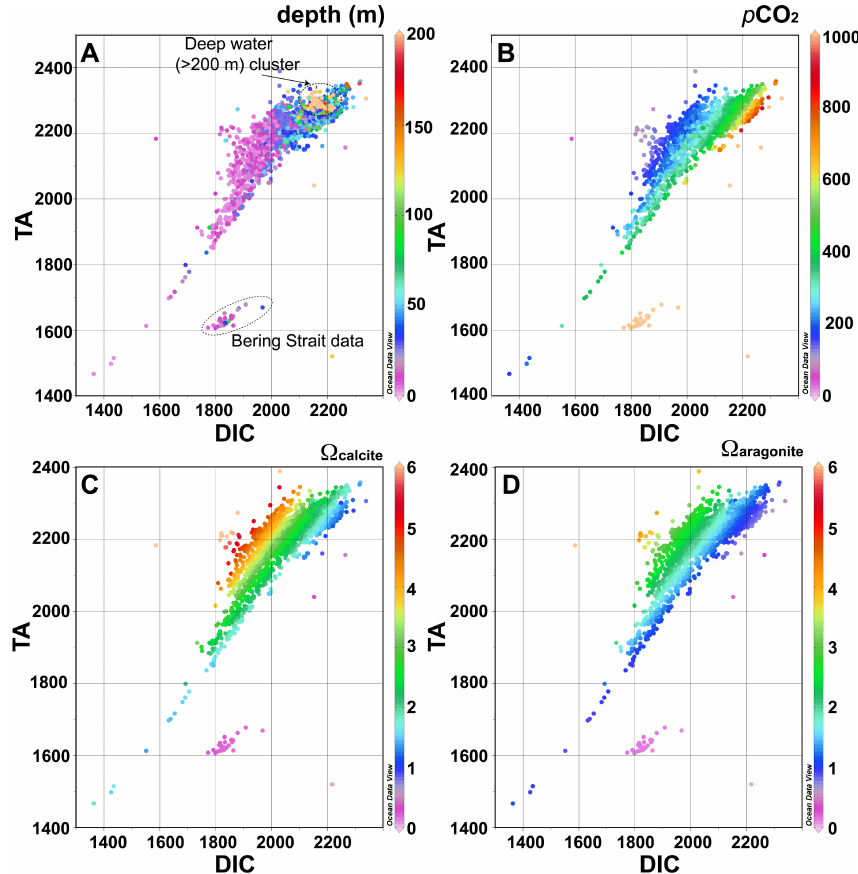
Fig. 3. Summertime scatter plots of depth, p CO 2 , (cid:127) calcite , and (cid:127) aragonite superimposed on DIC versus TA compiled for years 2009–2011 in the western Arctic Ocean (primarily Chukchi Sea but also eastern East Siberian Sea and western Beaufort Sea). The panels include (A) depth (m) – samples from depths greater than 200 m are denoted as a uniform color and represent offshelf samples in the Canada Basin; (B) p CO 2 (µatm); (D) pH; (C) (cid:127) calcite ; and (D) (cid:127) aragonite